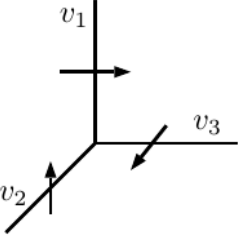
Figure 11: The topological vertex in the canonical